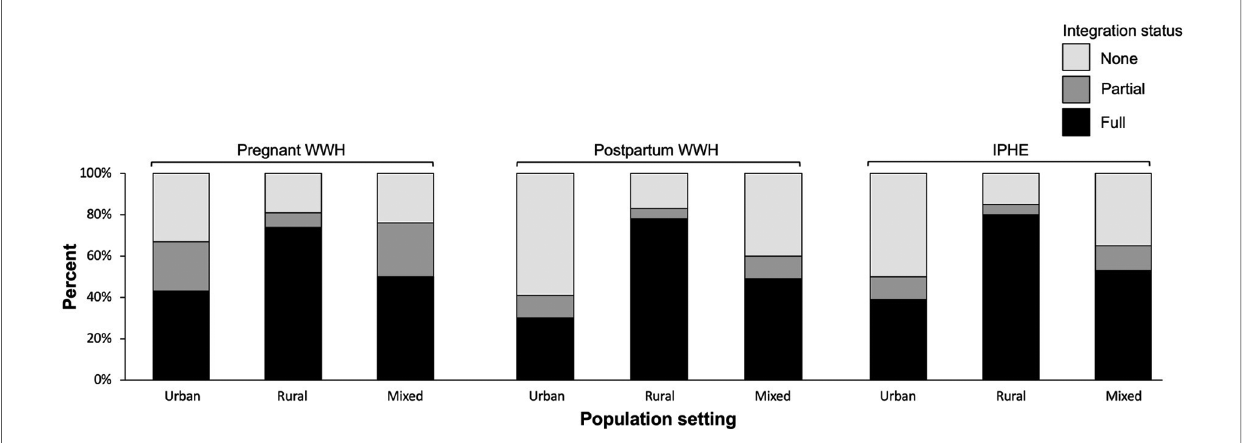
FIGURE 2 Integration of HIV and maternal and child health services, by urban and rural population setting, September 2020 to March